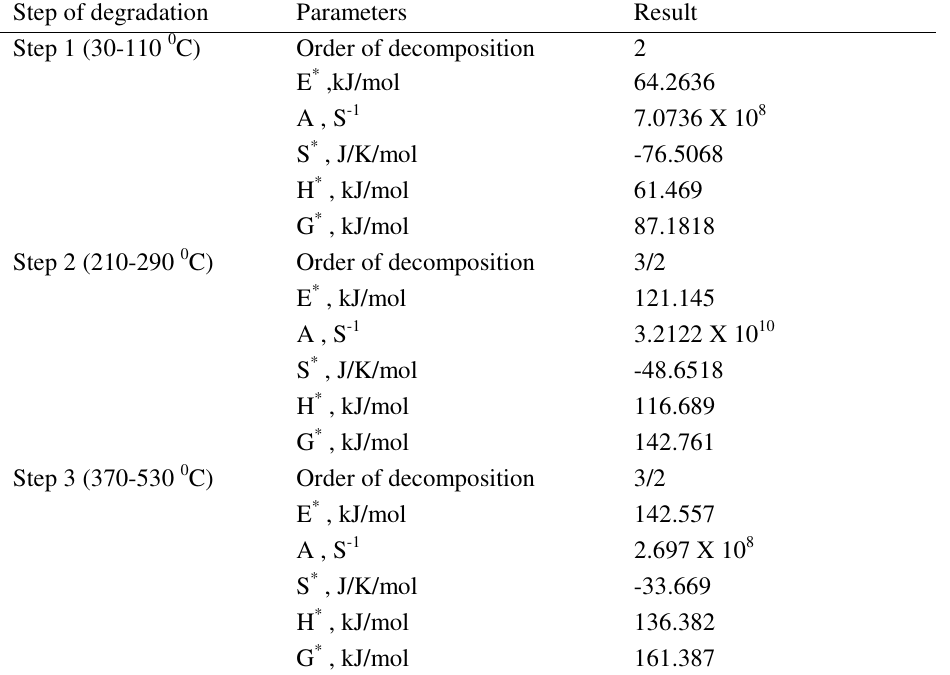
Table 1. Kinetic data of the thermal decomposition of the